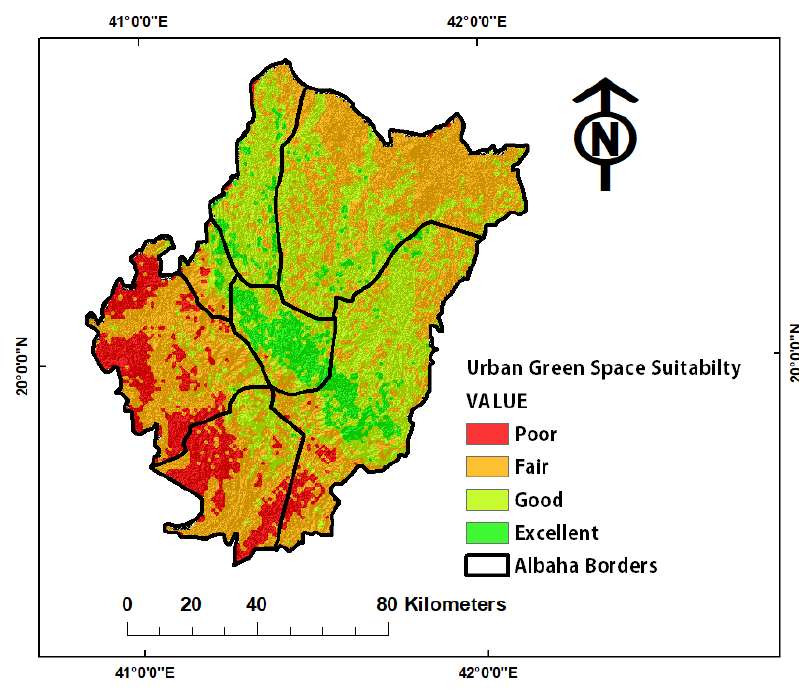
Figure 8. Suitability map for GI of the Al Baha region.